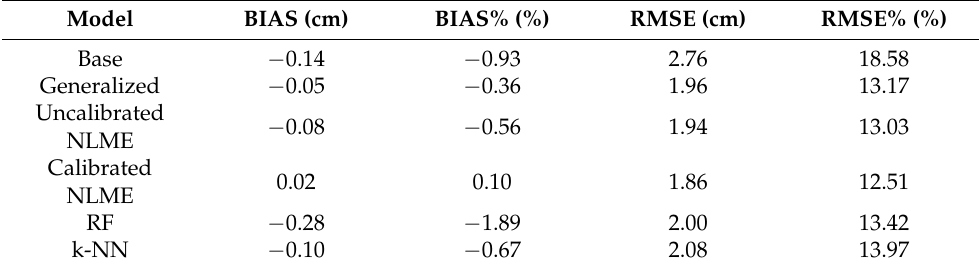
Table 3. Prediction accuracies of diameter at breast height (DBH) for the different